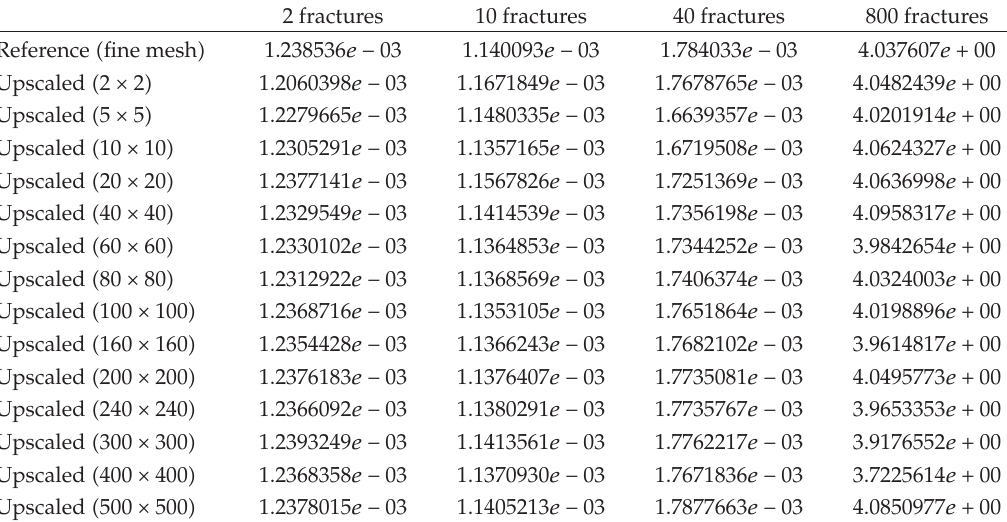
Table 1: Flux across the exit boundary for the di ff erent fractures and mesh